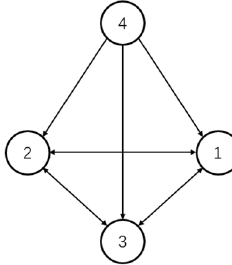
Figure 14. Four-vehicle communication topology diagram.